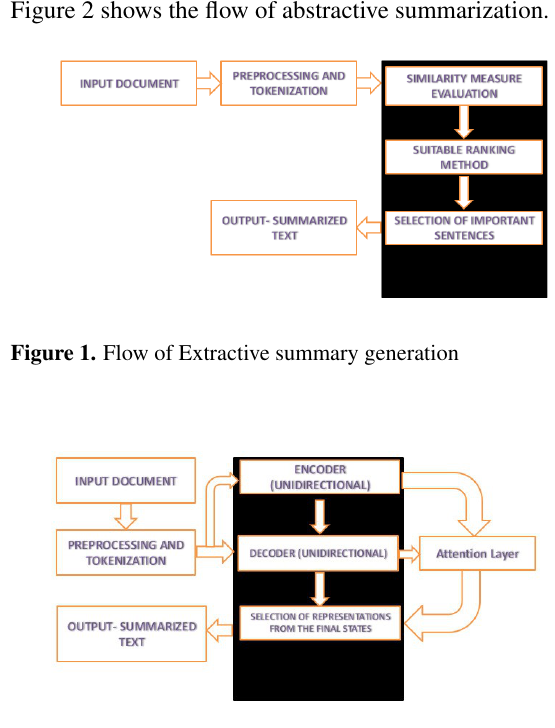
Figure 2. Flow of Abstractive summary generation